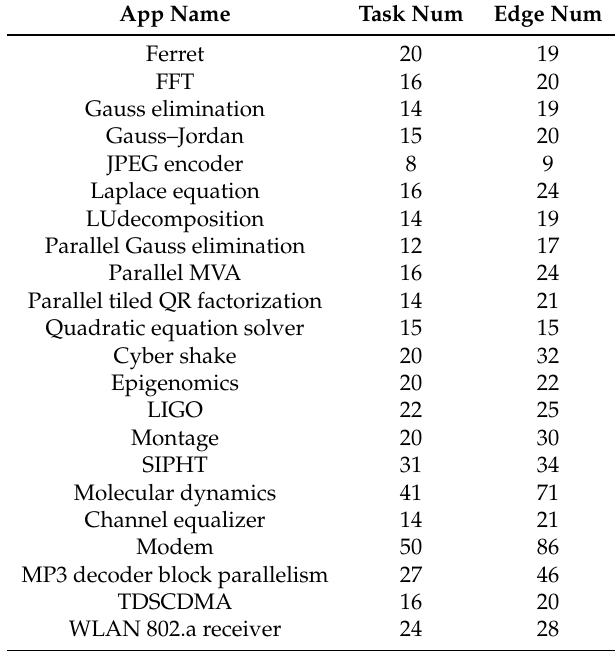
Table 3. Parameters of the set of real applications. MVA, mean value